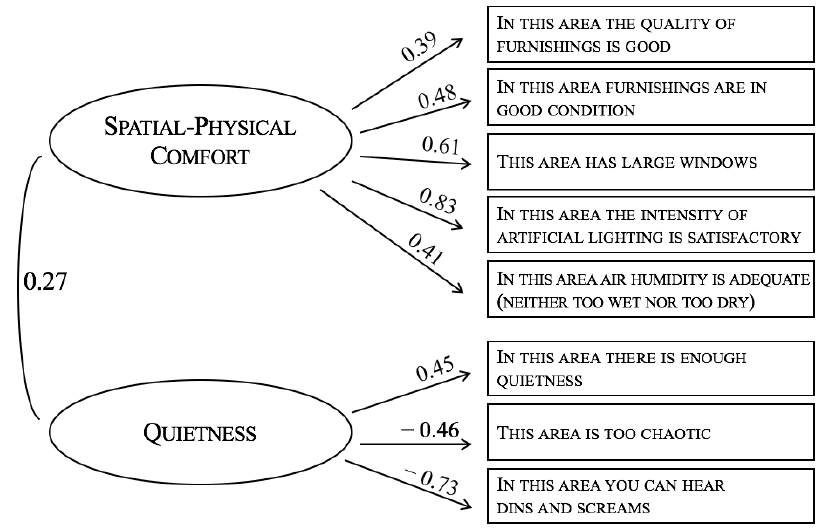
Figure 3. CFA. Interior common spaces.